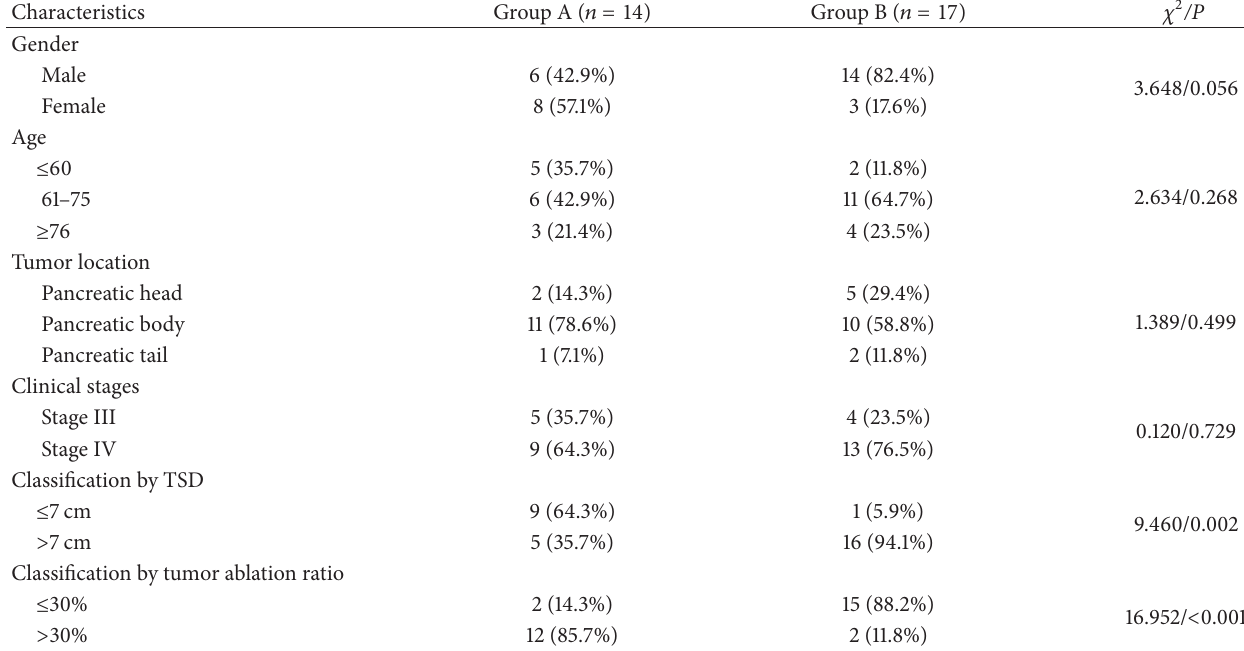
Table 3: The clinical condition and ultrasound grouping for 31 pancreatic